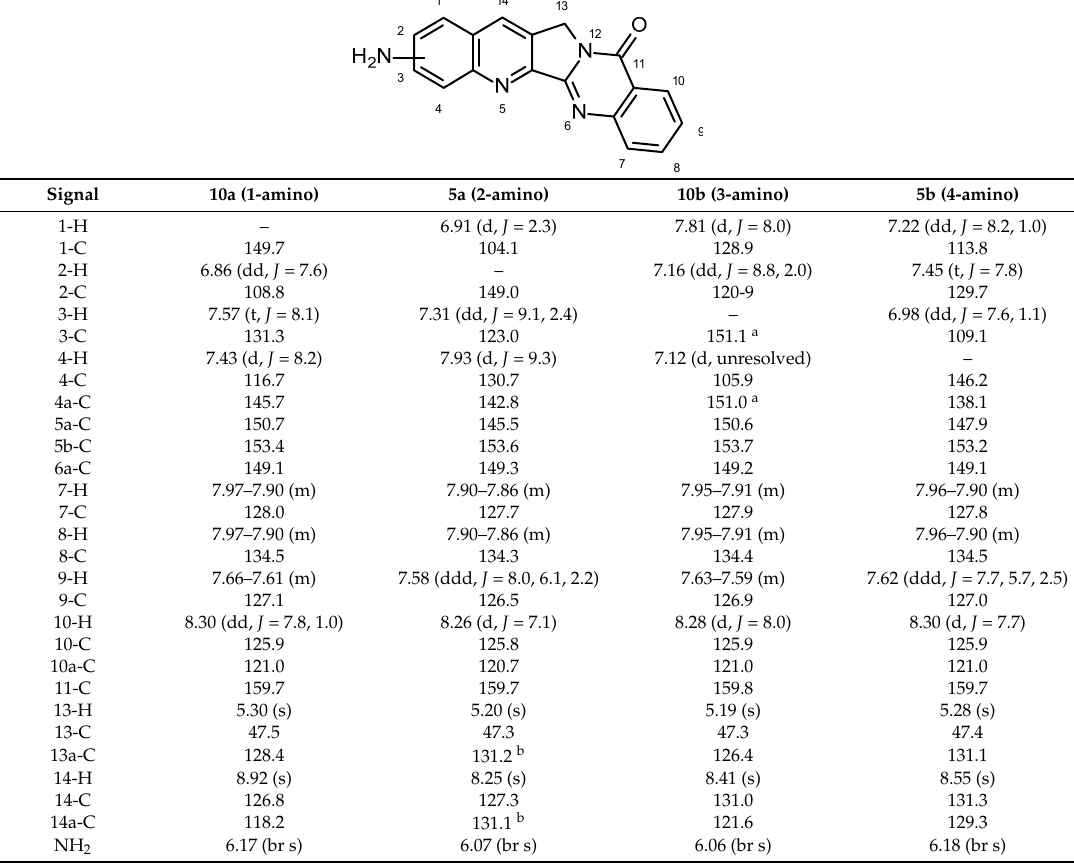
Table 1. 1 H-NMR (400 MHz) and 13 C-NMR (100 MHz) signals of the amino-substituted Luotonin A